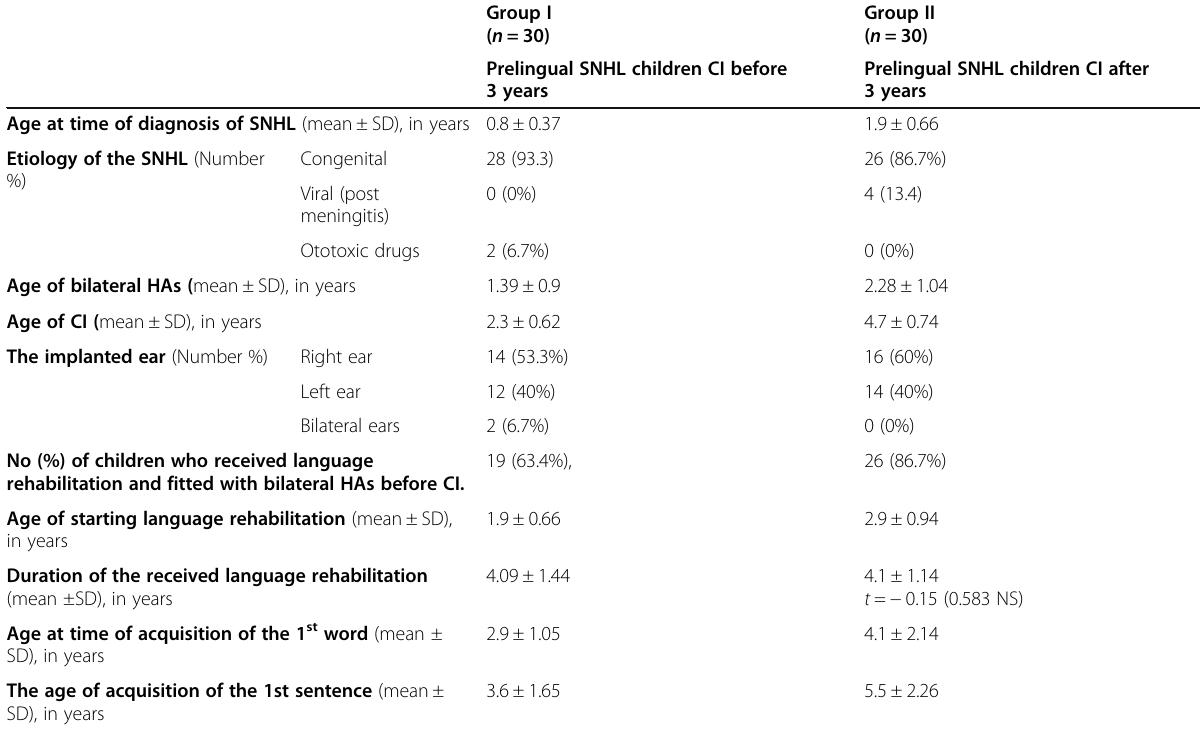
Table 2 Ages at time of diagnosis of SNHL, at time of cochlear implantation, at the time of starting language rehabilitation, etiology of the SNHL, laterality of the implanted ear, ages of acquisition of the 1st word/sentence, duration of the received language rehabilitation Group I ( n =